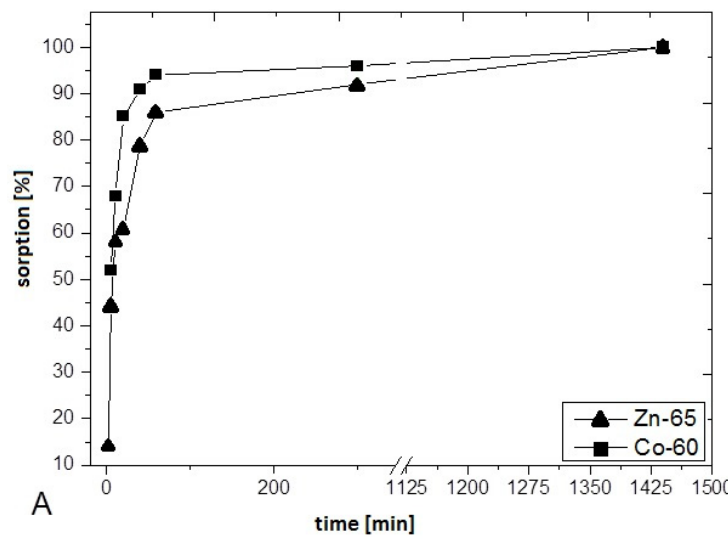
Figure 3. Sorption percentages of 60 Co and 65 Zn on TiO 2 nanotubes as a function of time at pH = 4.